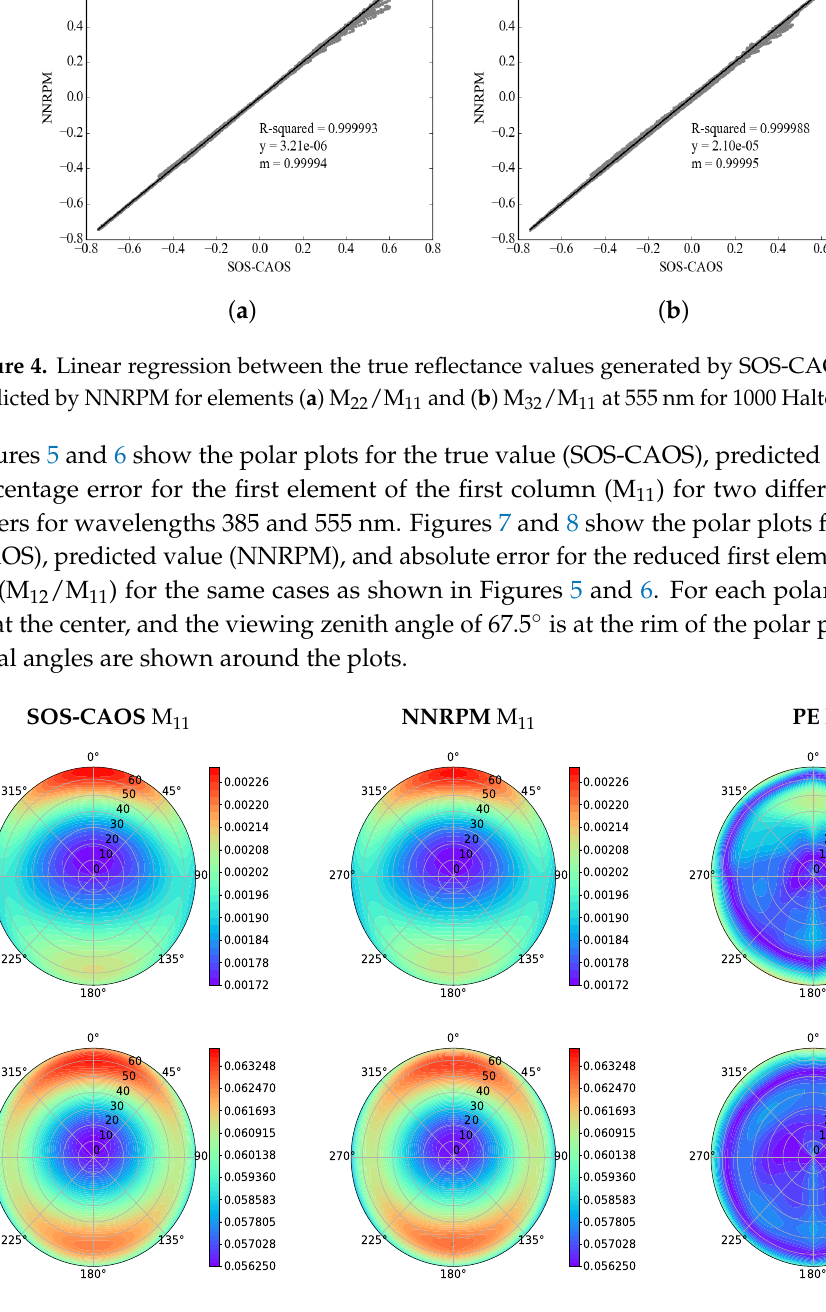
Figure 5. Polar plots of SOS-CAOS, NNRPM and PE for M 11 at wavelength 385 nm. Input parameters for Top Row: θ i = 55.91 ◦ , Chla = 20.43 mg/m 3 , a dg ( 440 ) = 7.36 m − 1 , b bp = 0.097 m − 1 , B p = 0.015, S Bp = − 0.157 nm − 1 , S bp = 0.258 nm − 1 , S dg = 0.019 nm − 1 . Input parameters for Bottom Row: θ i = 43.02 ◦ , Chla = 24.77 mg/m 3 , a dg ( 440 ) = 0.004 m − 1 , b bp = 0.099 m − 1 , B p = 0.046, S Bp = − 0.106 nm − 1 , S bp = 0.023 nm − 1 , S dg = 0.014 nm − 1